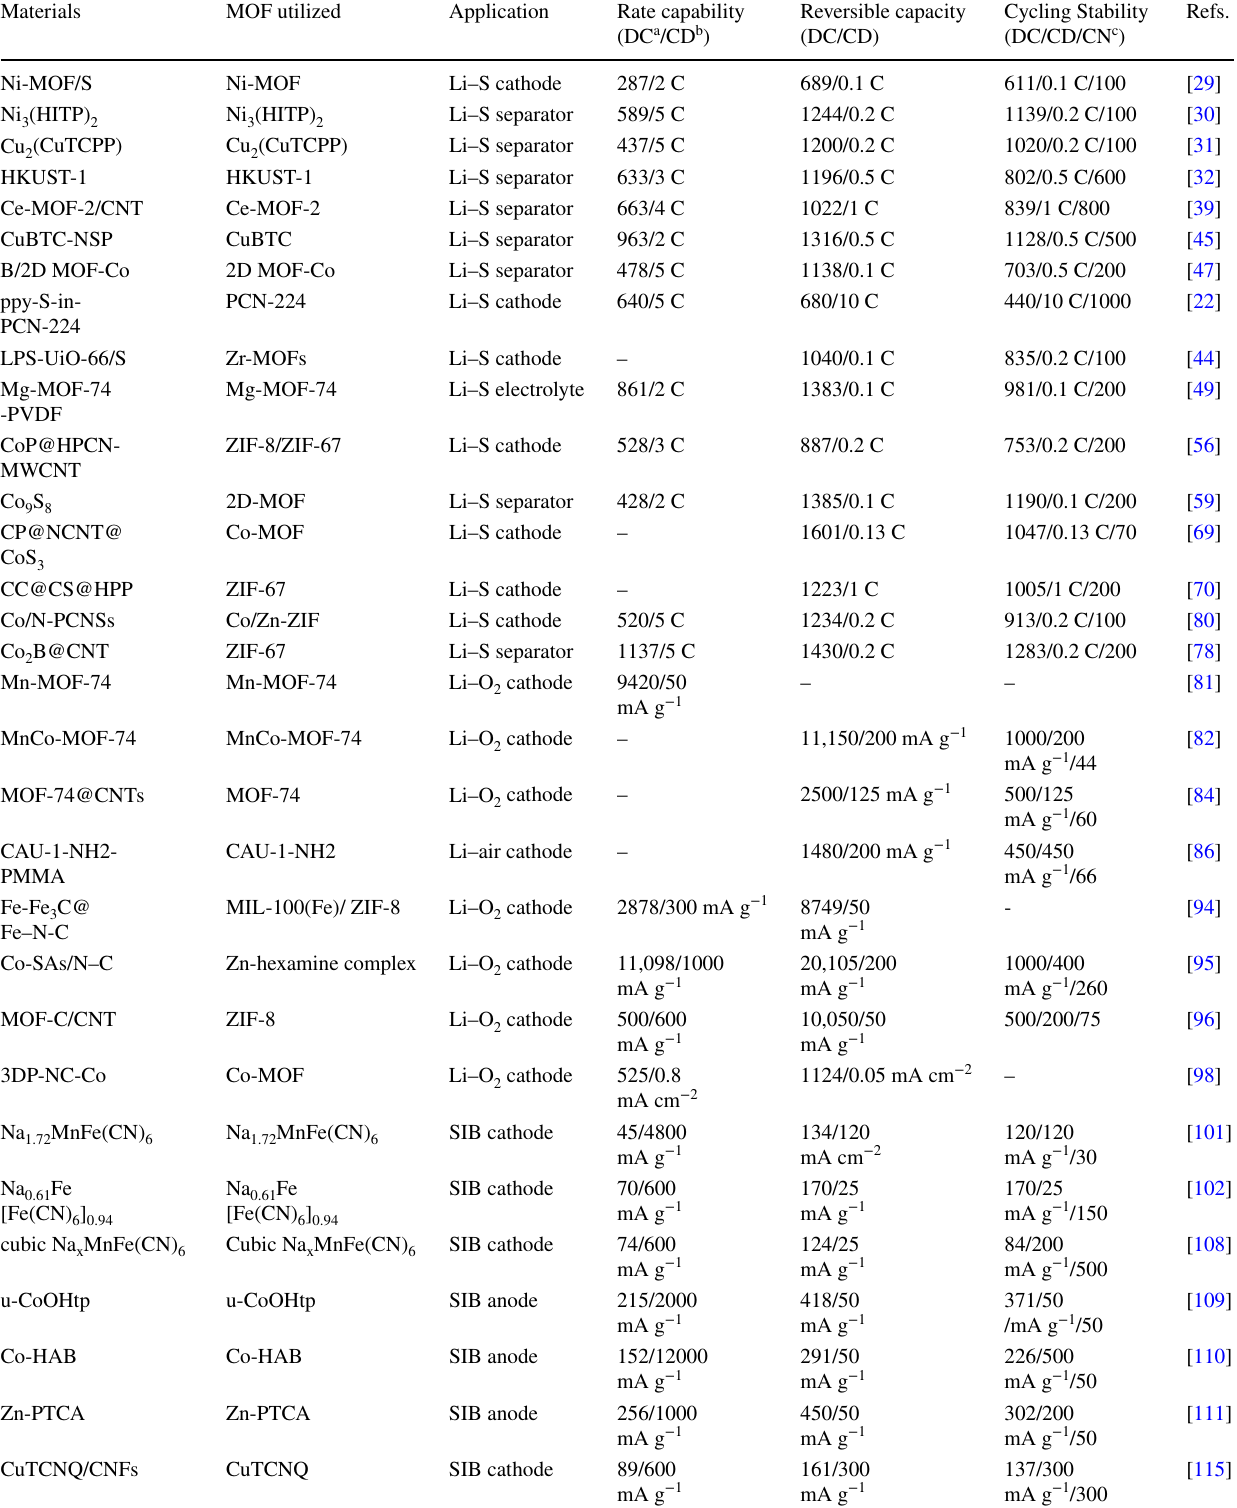
Table 1 Summary of the representative MOF-related materials for next-generation batteries